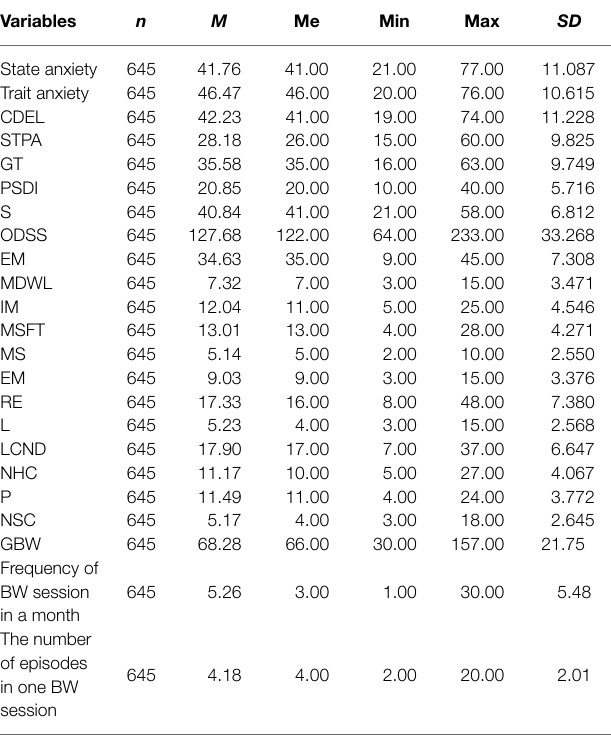
TABLE 1 | Descriptive statistics for the intensity of researched variables.